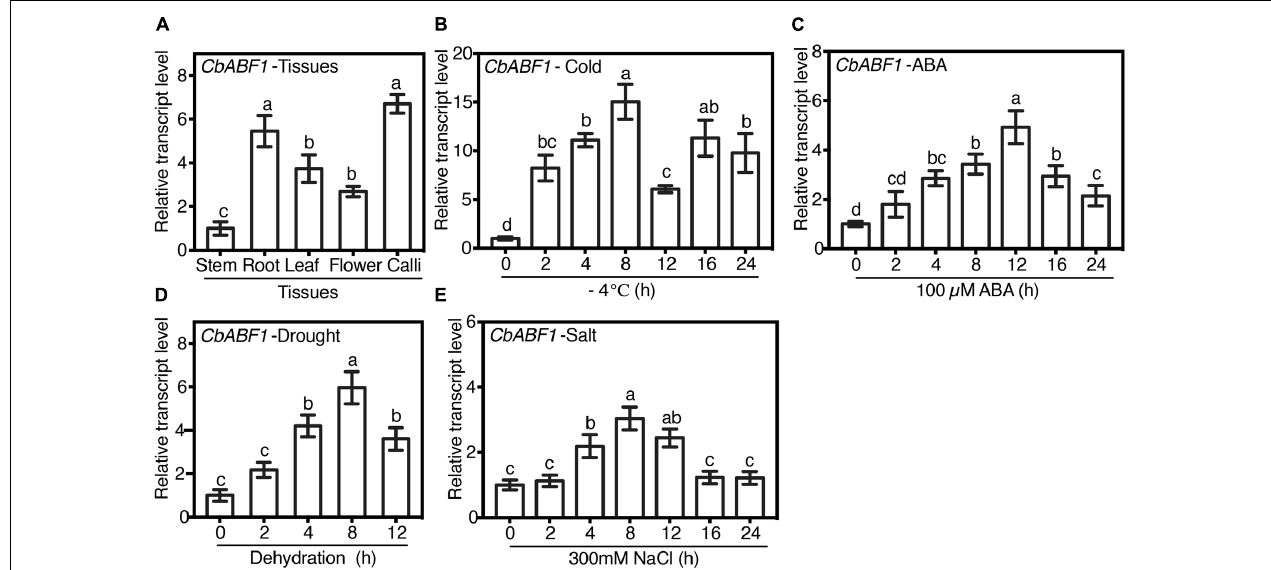
FIGURE 3 | Expression profiles of CbABF1 . (A) Expression of CbABF1 in different tissues. The cDNAs for analysis were prepared from the regenerated plants and calli of C. bungeana . The stem value was defined as 1.0, and the expression levels in other tissues were normalized accordingly. (B–E) Expression profiles of CbABF1 in response to abiotic stresses. Two-week old sub-cultured Chorispora bungeana seedlings were subjected to cold (–4 ◦ C), abscisic acid (ABA, 100 µ M), or salt (NaCl, 250 mM) for 0–24 h, or drought (shoots were placed on filter paper) treatments for 0–12 h. For each assay, the expression level at time point 0 was defined as 1.0, and the expression levels at other time points were normalized accordingly. C. bungeana ACTIN ( CbACTIN ) was used as the internal control for qRT-PCR analysis. Error bars represent SD ( n = 3). One-way ANOVA (Tukey test) was performed, and statistically significant differences are indicated by different lowercase letters ( P < 0.01). Values shown are derived from experiments that were performed at least three times with similar results, and representative data from one repetition are